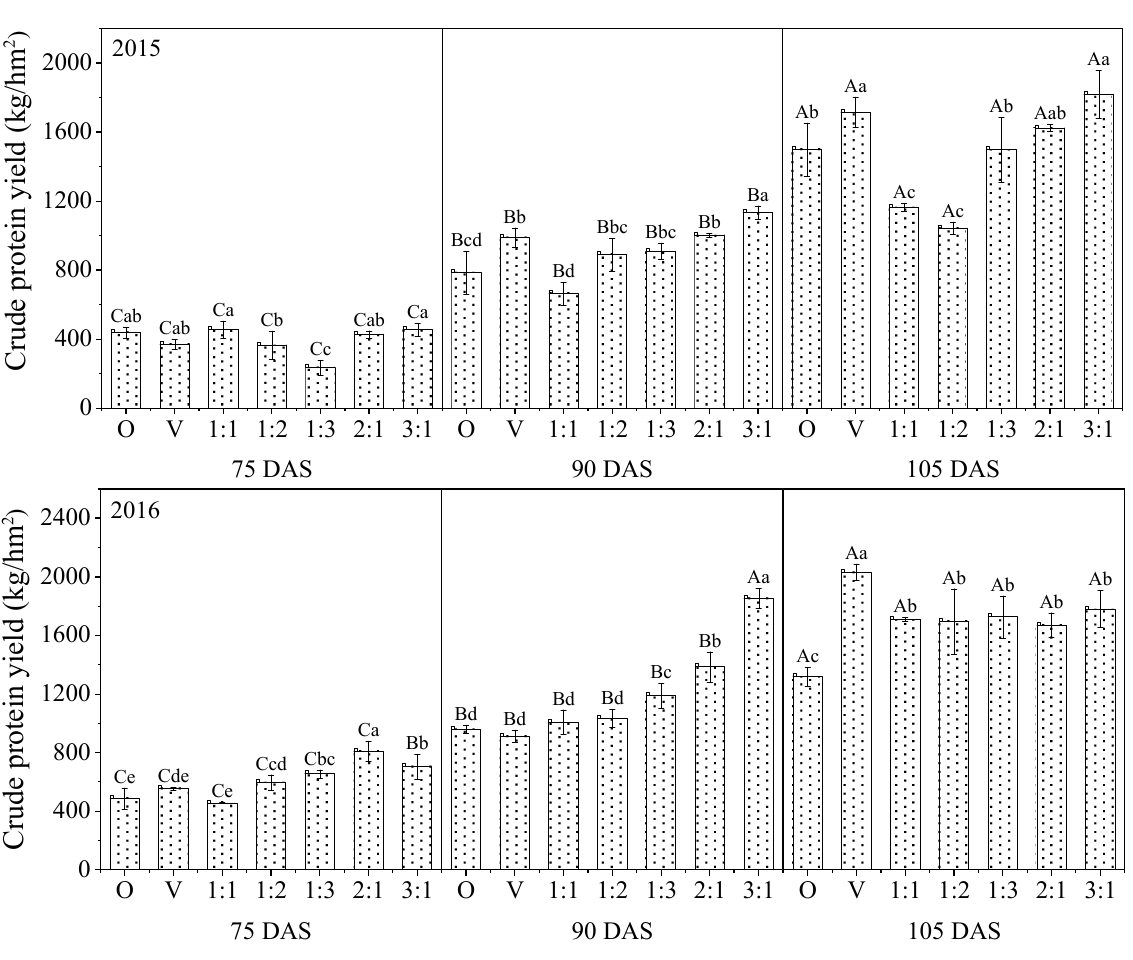
Figure 2. The effect of different intercropping ratios of oat and common vetch on crude protein yield of forage.